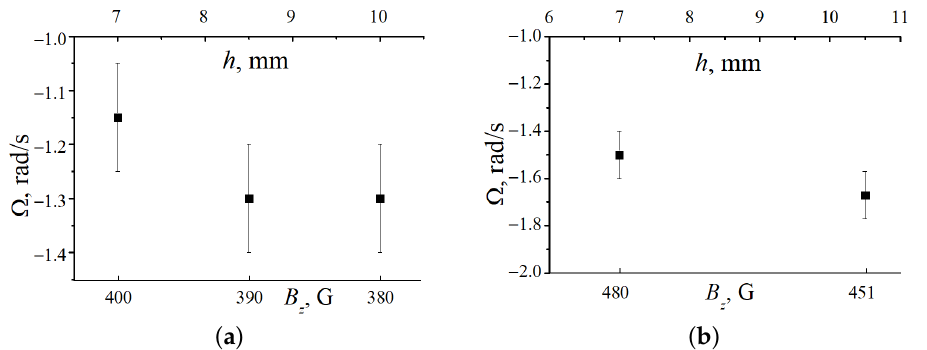
Figure 4. Dependences of the angular velocity of the dust structure rotation in striation VI on the vertical coordinate h at p = 0.27 Torr. ( a ) I = 1.5 mA, on the interval of 7–10 mm, the magnetic field varies from 400 to 380 G. ( b ) I = 1.4 mA, in the interval of 7–10.5 mm, the magnetic field varies from 480 to 451 G.